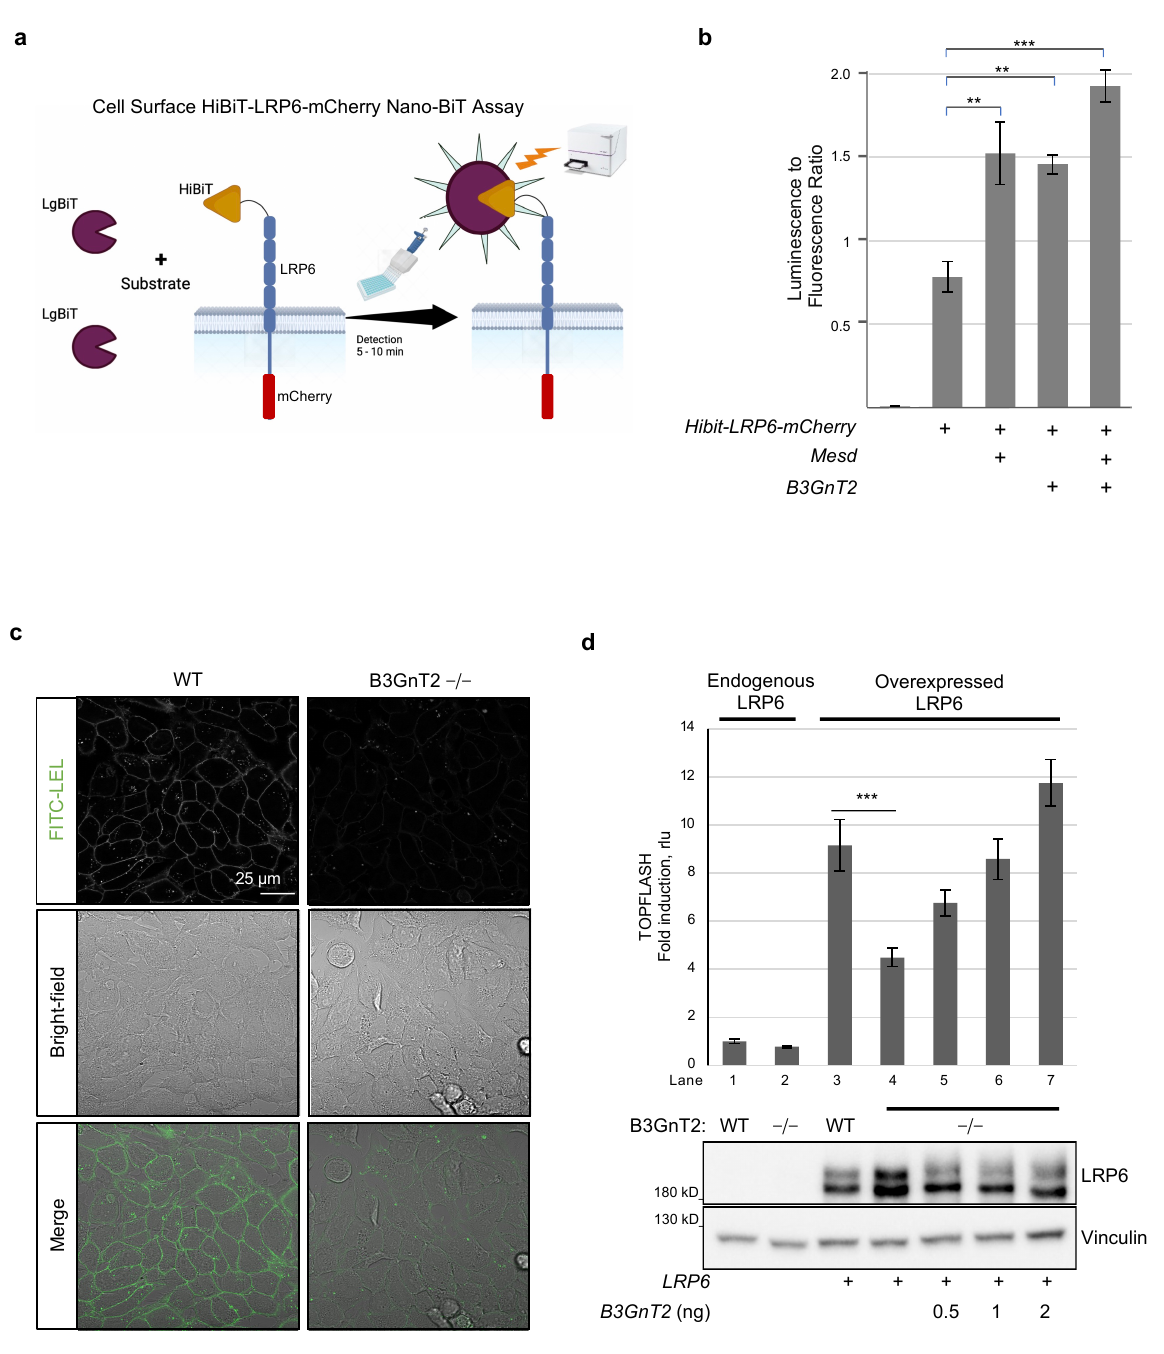
here show that B3GnT2 functions to promote the synthesis of polylactosamine units on multiple N -glycans of LRP6 to activate Wnt/ β -catenin signalling.